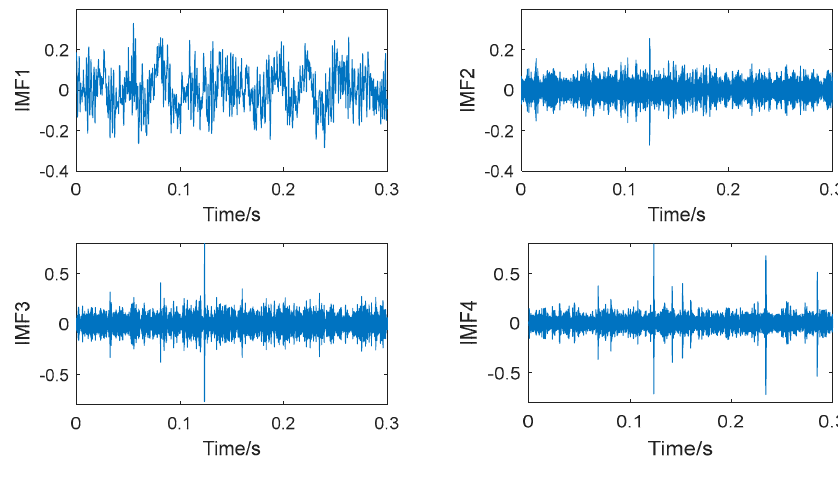
Figure 10. Normal state signal VMD.